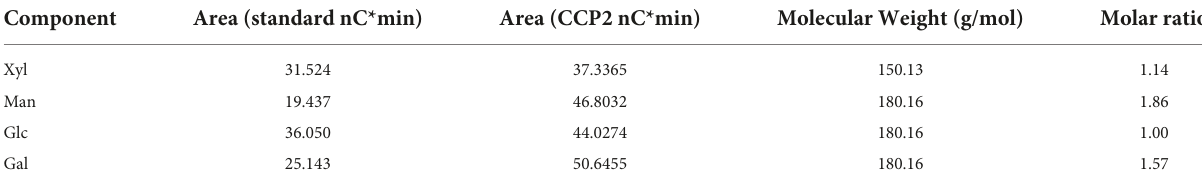
TABLE 2 Monosaccharide composition of CCP2.